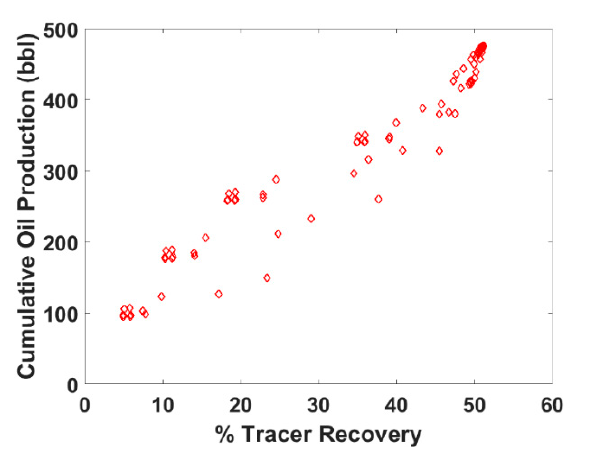
Figure 25. Cumulative oil production vs. tracer recovery.